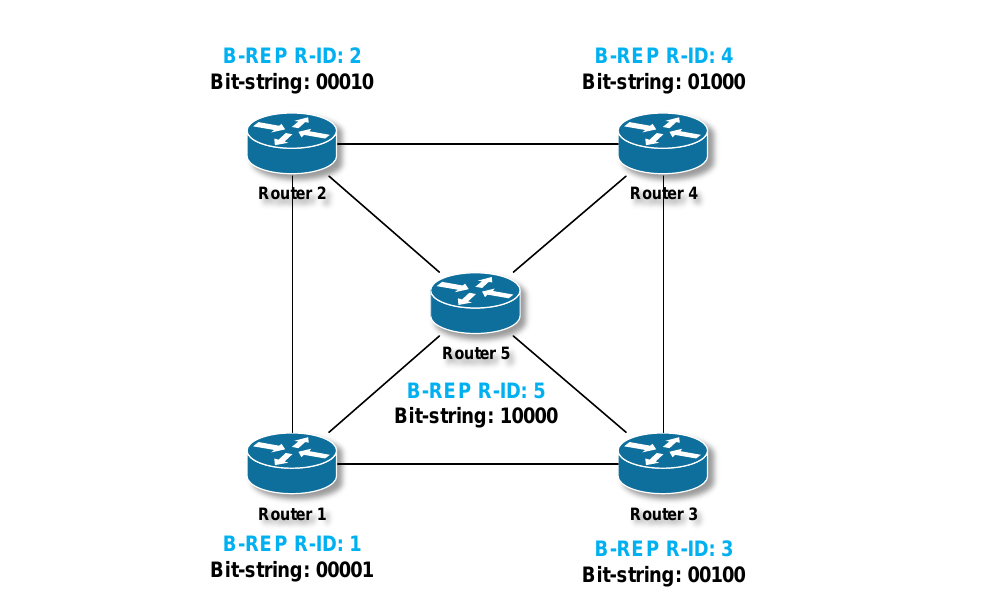
10 of 31 Table 2. B-REP Table — Bit-String allocation according to B-REP R-ID. Router